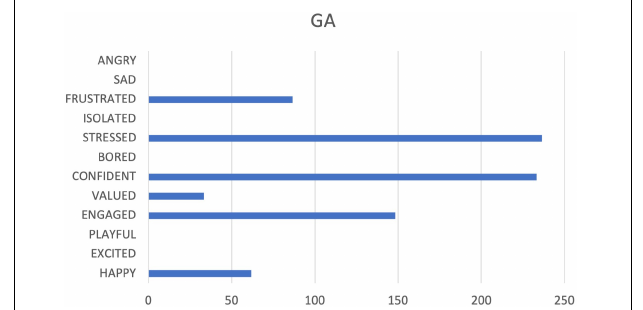
FIGURE 6 | Cumulative frequencies of GA data